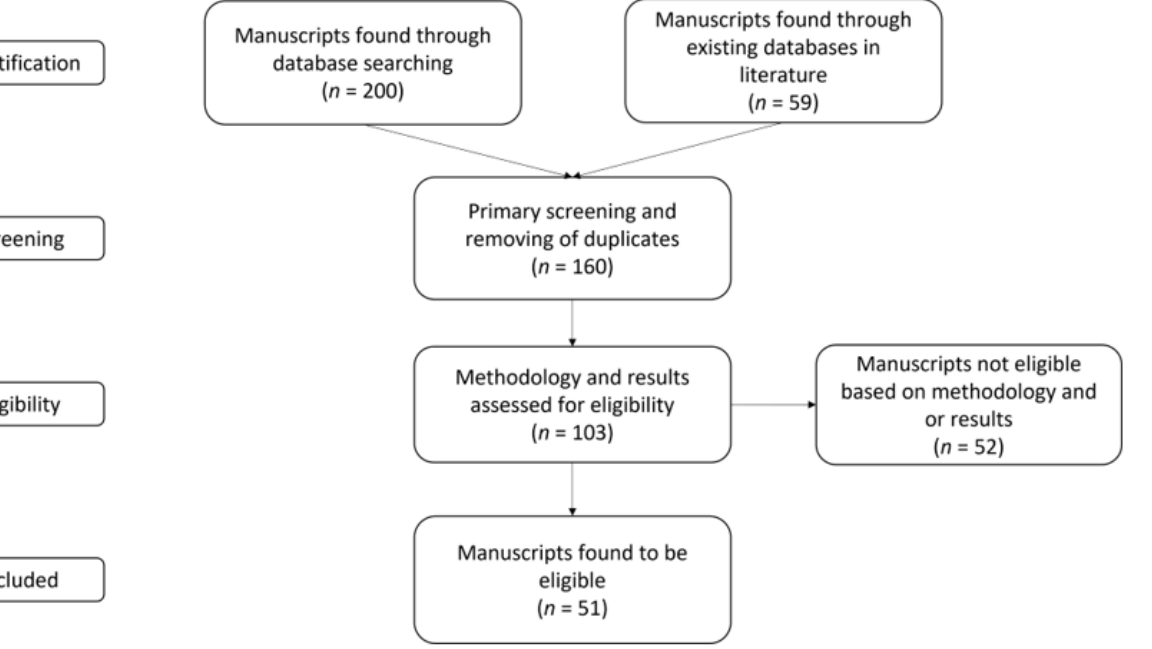
Figure 1. PRISMA flow diagram of the systematic review from the number of manuscripts identified by the search engine and other sources to initial screening, determining eligibility, to the final number of manuscripts included in the data frame. The n refers to the number of manuscripts.